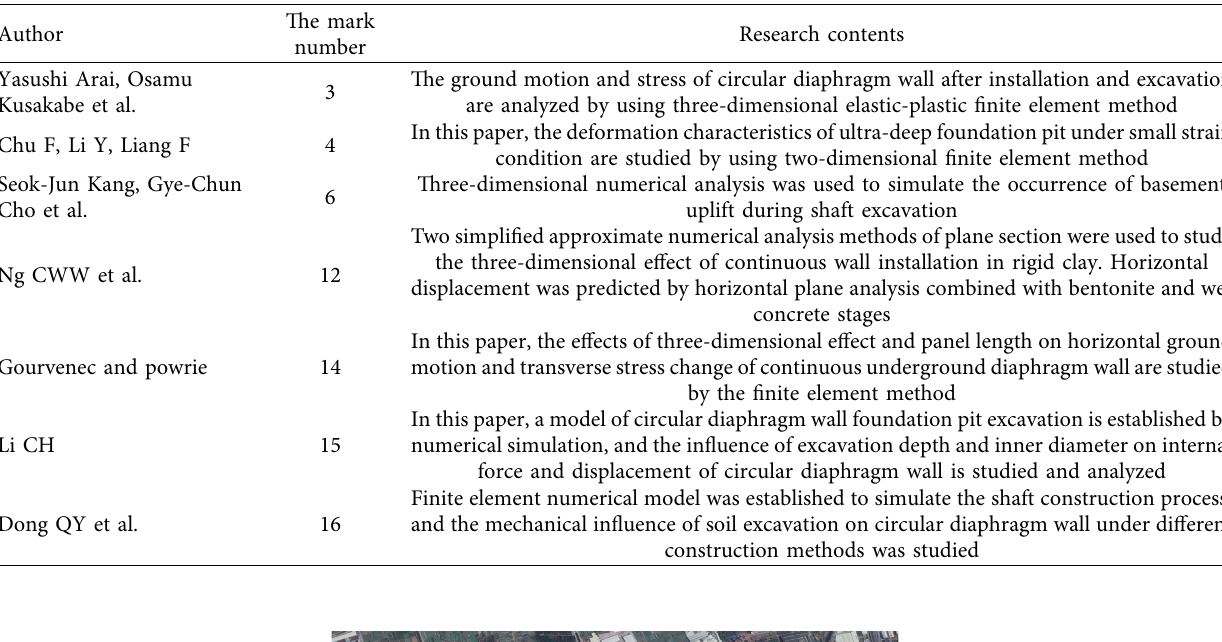
Table 1: Finite element research literature representing displacement.